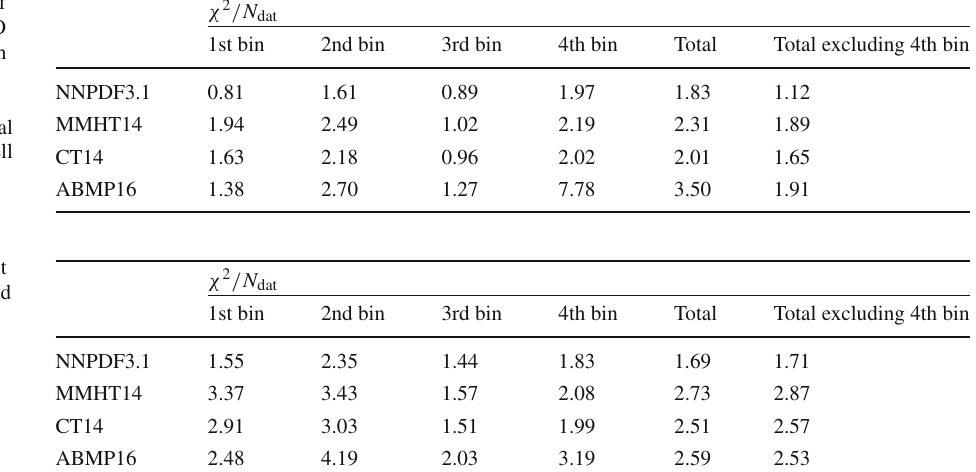
Table 1 The χ 2 / N dat values of the 8 TeV ATLAS using NNLO QCD theory supplemented with